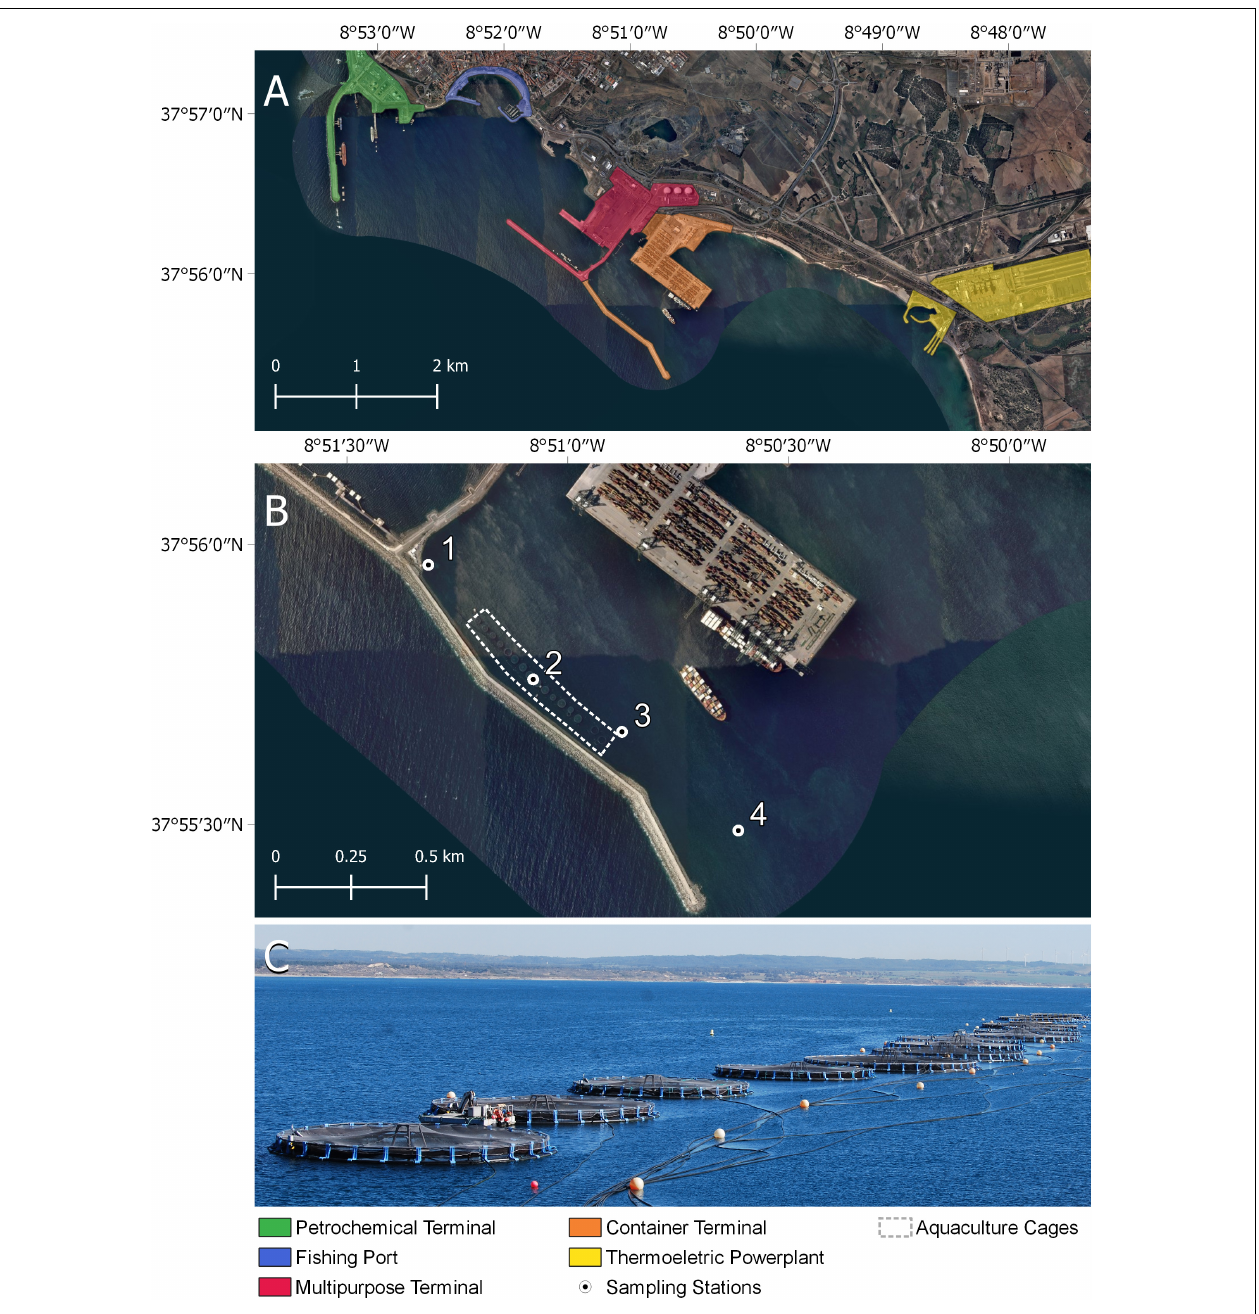
FIGURE 1 | The study site: (A) overview of the Sines coast, highlighting the main infrastructures depending on the ocean; (B) aquaculture location inside the container terminal; (C) production cages (viewpoint from the ground facilities, near Station 1).